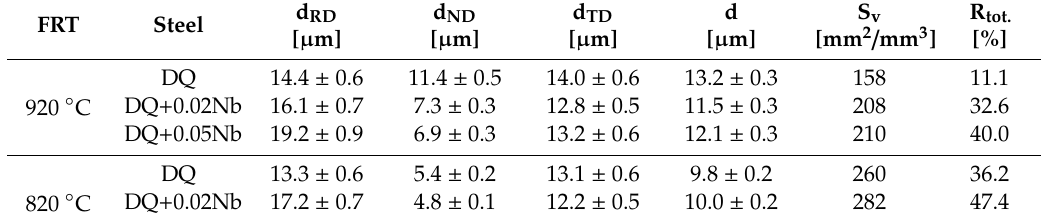
Table 5. Prior austenite grain structure parameters and estimated total reduction in the T NR regime.